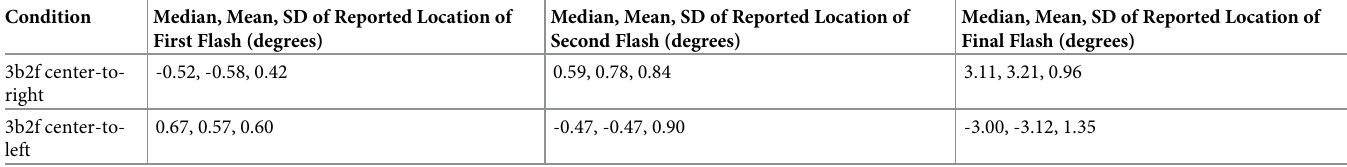
Table 2. Experiment 1.3 Prior knowledge of stimuli direction with location. Condition Median, Mean, SD of Reported Location of First Flash